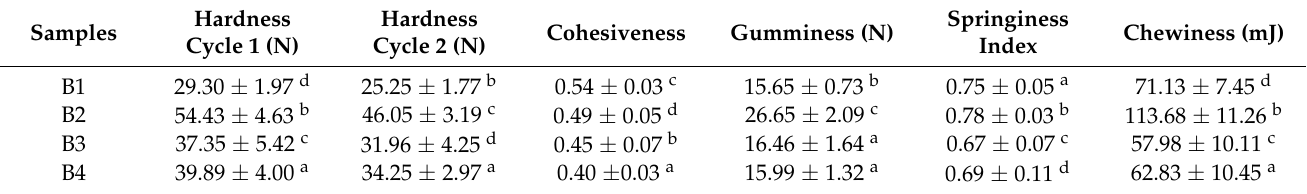
Table 8. Results of texture profile analysis (TPA) for fermented salami with different sources of fermenting